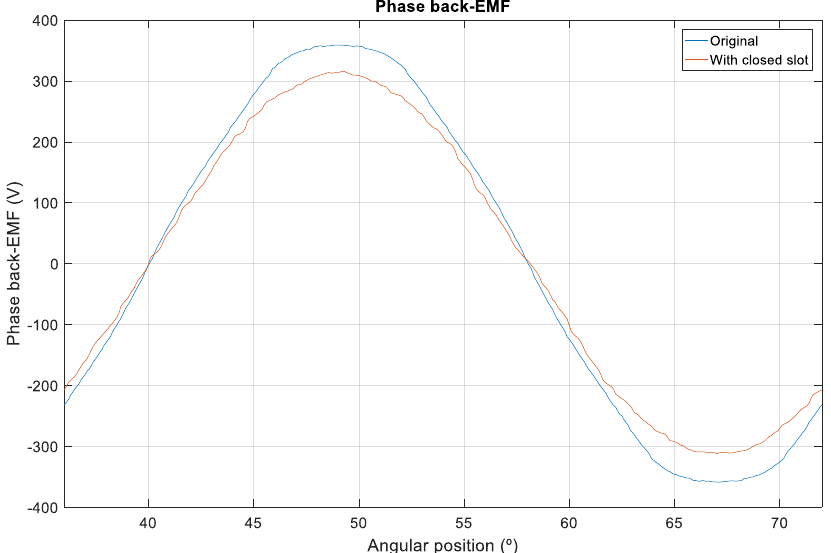
Figure 5. Effect of closed slots in back electromotive force (EMF). Energies 2018 , 11 , x FOR PEER REVIEW